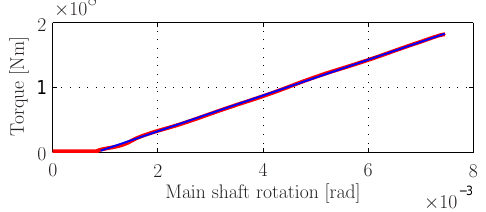
Figure 11: Torque as function of main shaft rotation